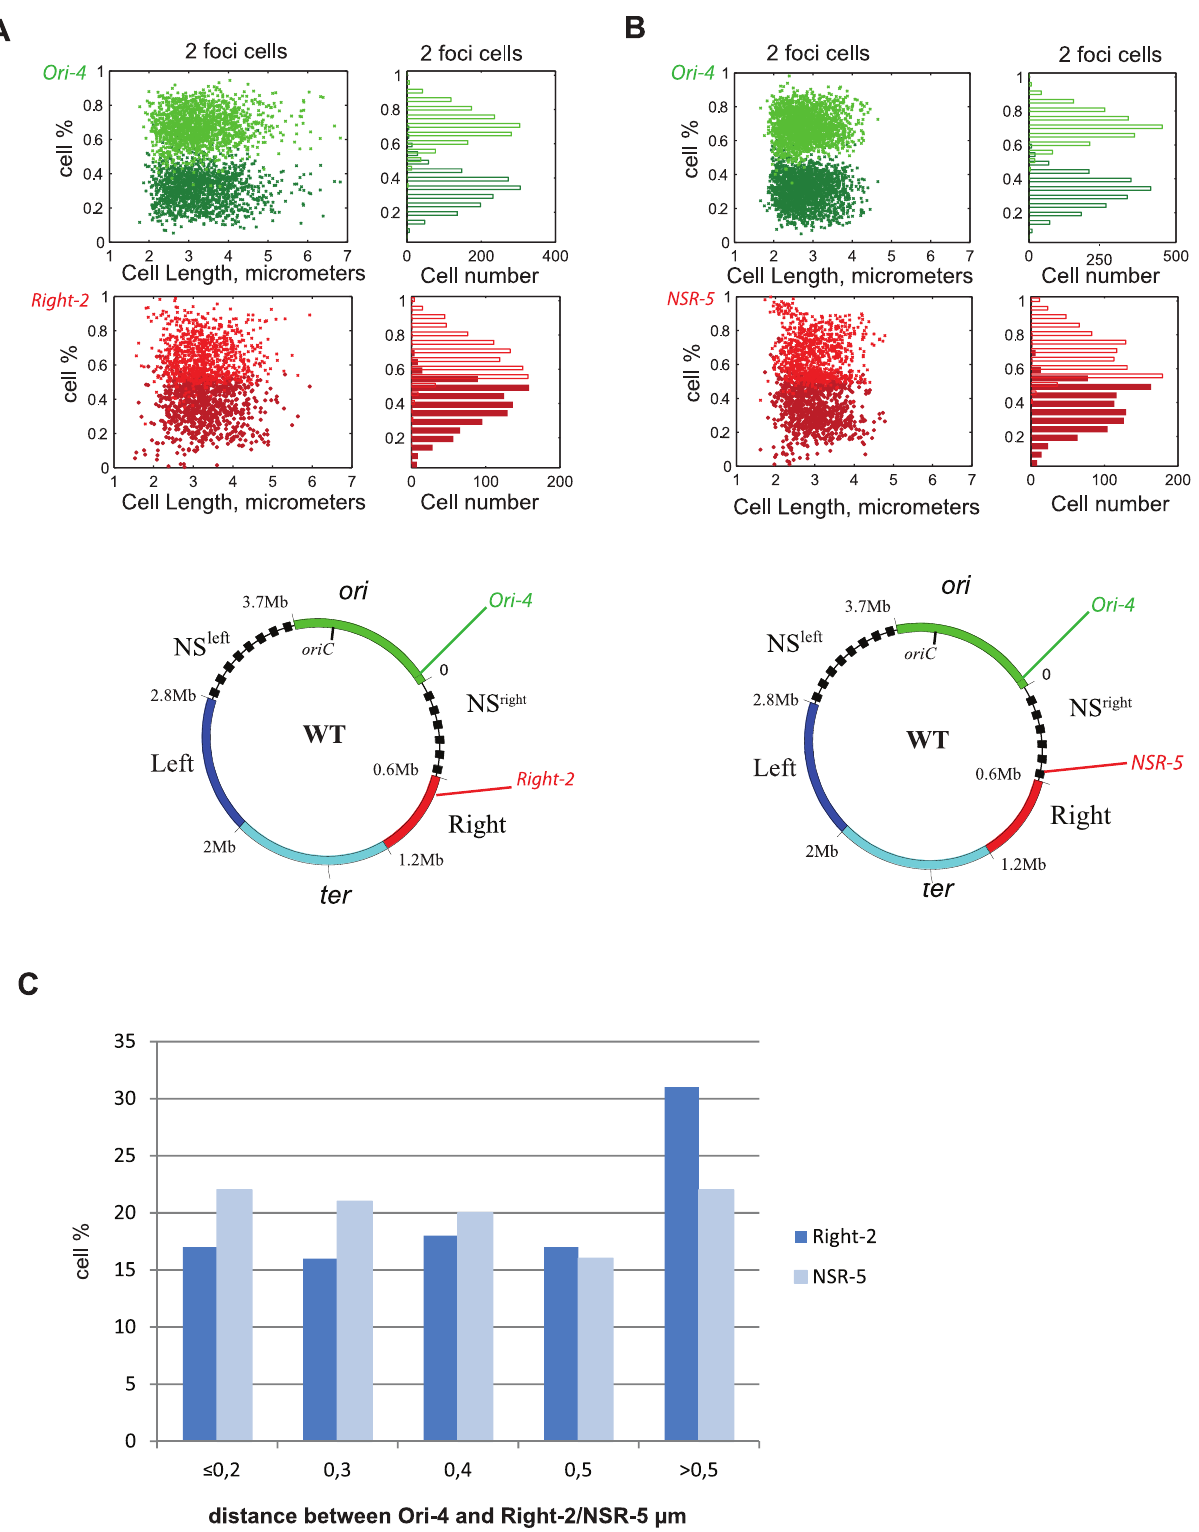
Fig 5. Position of chromosomal loci in the Ori, NSR region and Right MD. MD maps of the E . coli chromosomeare represented with the position of the Ori-4, Right-2, NSR-5 FROS-Tag in a WT strain. For each panel, the positionof foci in cell containing2 foci, are